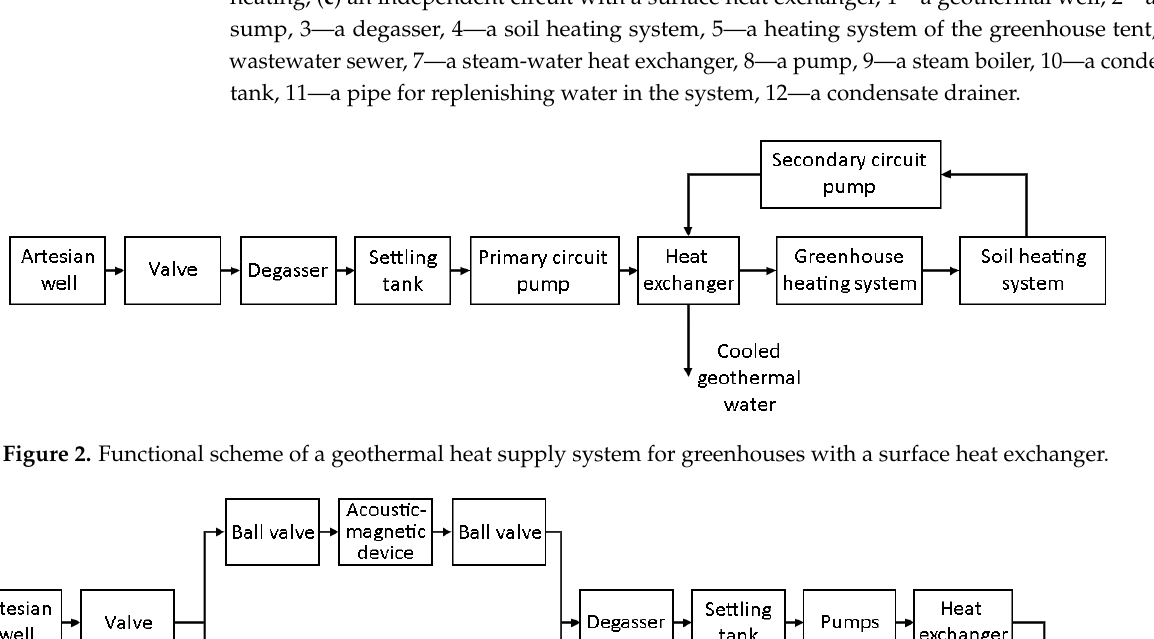
Figure 2. Functional scheme of a geothermal heat supply system for greenhouses with a surface heat exchanger.